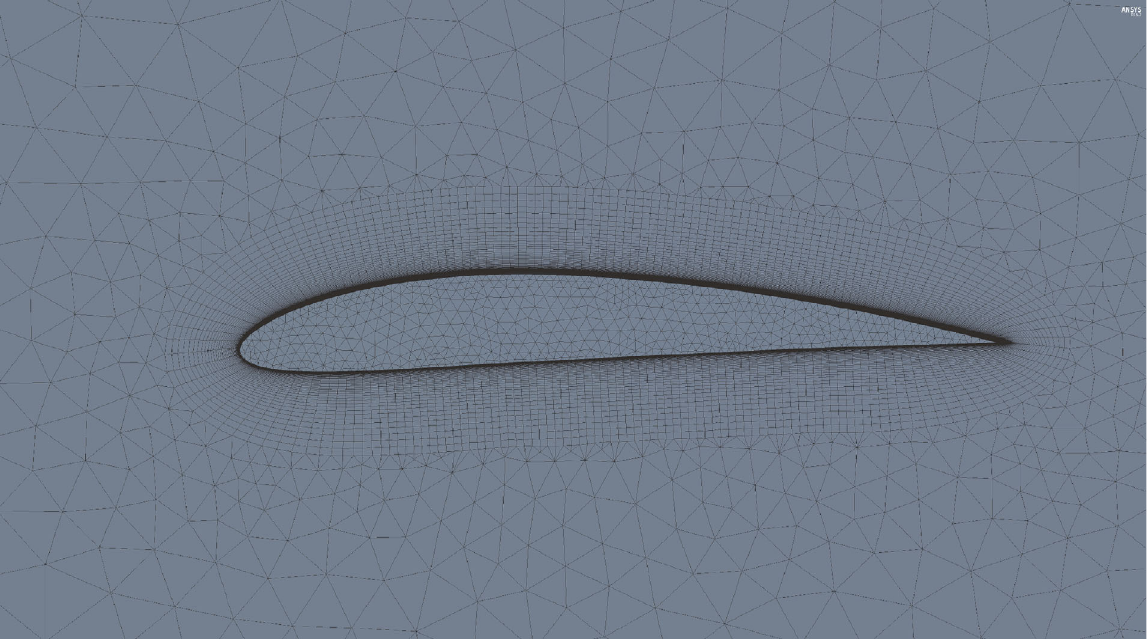
Figure 3: Cells around the airfoil at c